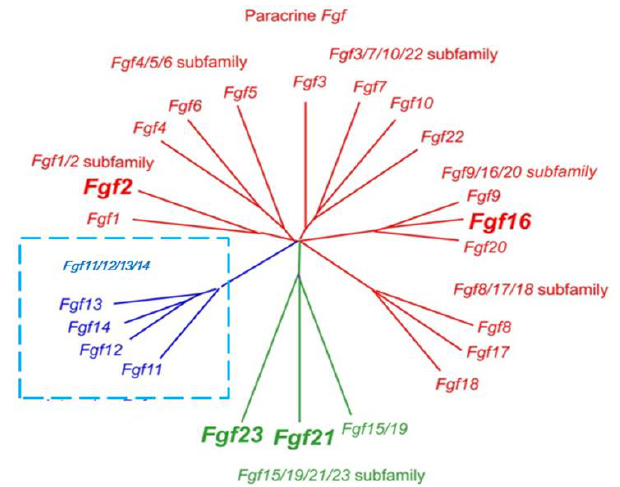
Figure 1. Evolutionary relationships within the human/mouse Fgf gene family by phylogenetic analysis. Phylogenetic analysis suggests that 18 mammalian FGFs are classified into six subfamilies containing five paracrine subfamilies and an endocrine subfamily. FGF members such as FGF11-FGF14 are not classified into the above six subfamilies because they cannot activate FGF receptors.